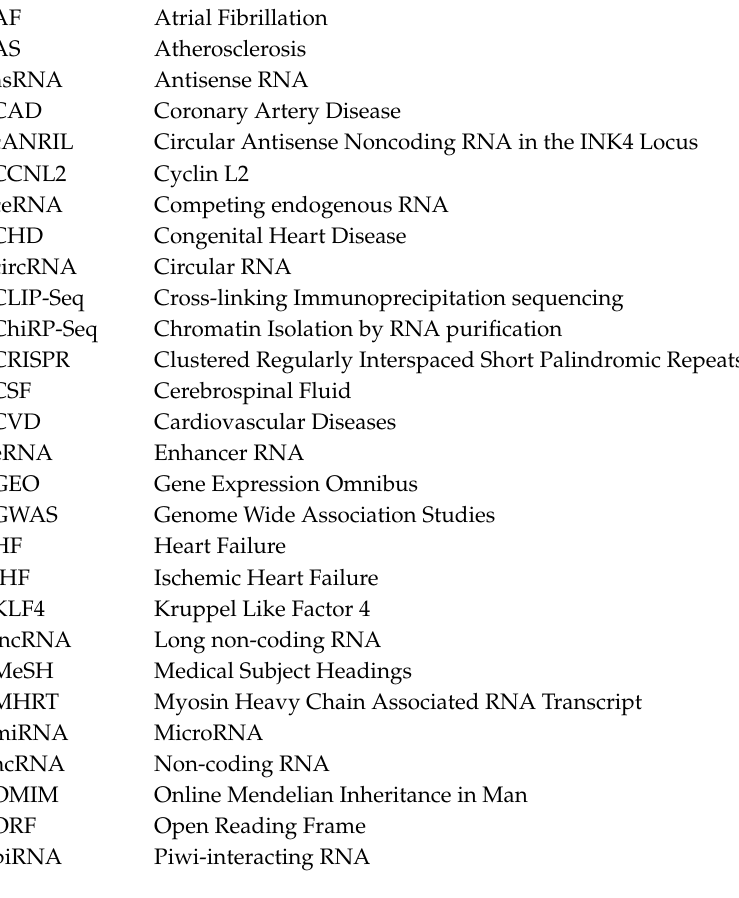
Table S1: List of ncRNA databases with additional information on the database, manuscript, and year of